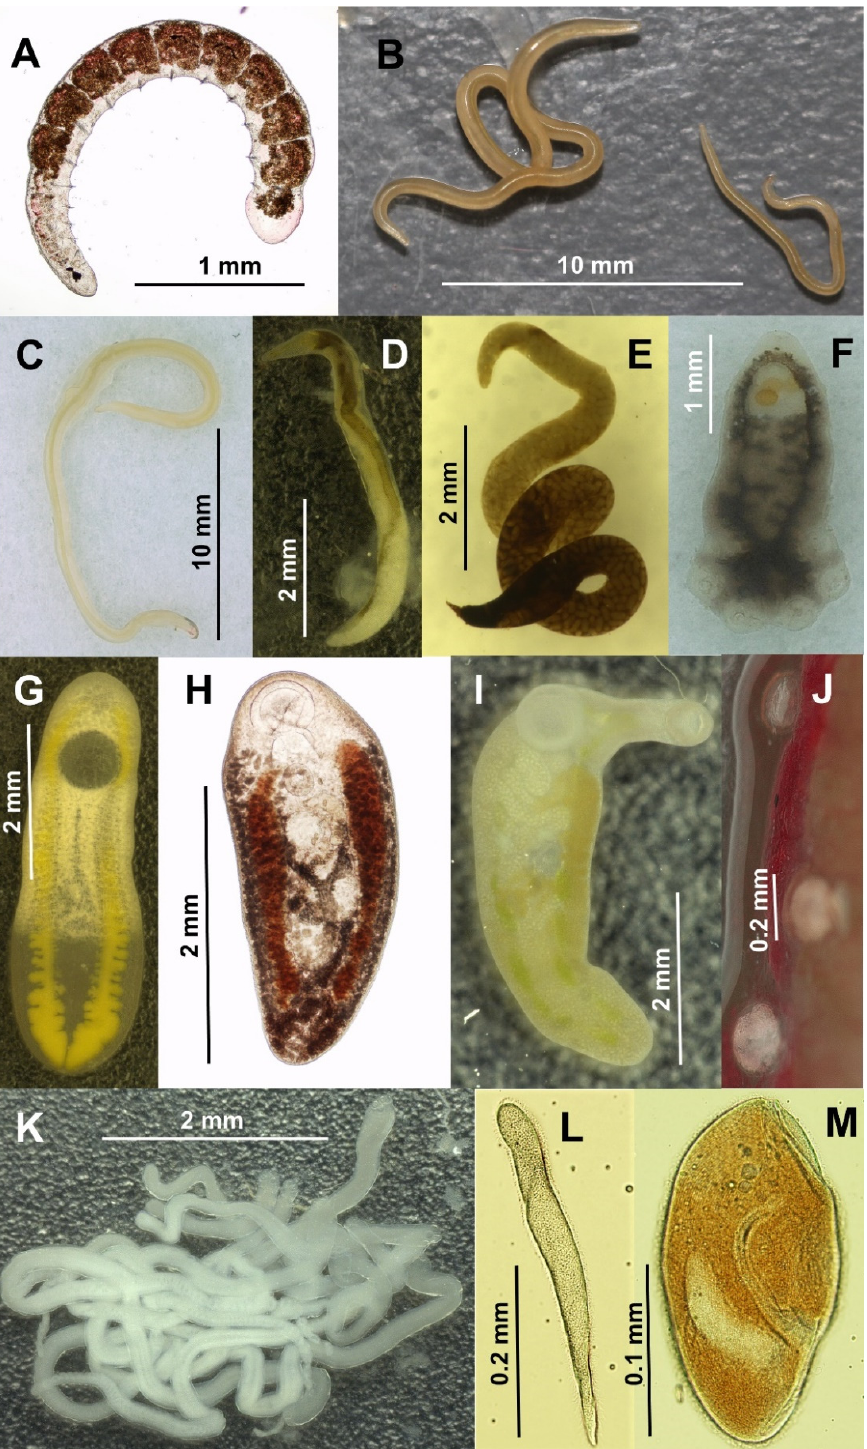
Figure 2. Endoparasite and endocommensal species detected in H. kivuensis and H. viridiflavus . ( A ) Dero rwandae (HK); ( B ) female (left) and male (right) Orneoascaris chrysanthemoides (HK, HV); ( C ) male O. schoutedeni (HK, exclusively in Musanze); ( D ) female Aplectana chamaeleonis (HK); ( E ) Rhab- dias collaris (HV); ( F ) Polystoma sp. (HV); ( G ) Clinostomum chabaudi (HK, HV); ( H ) Glypthelmins africana (HV); ( I ) Gorgoderina africana (HV); ( J ) three undetermined echinostomatid metacercariae (HK, HV); ( K ) five Nematotaenia sp. individuals (HV); ( L ) Protoopalina sp. (HK, HV); ( M ) Nyctotherioides sp. (HK, HV). Bars represent the scale of each photo.